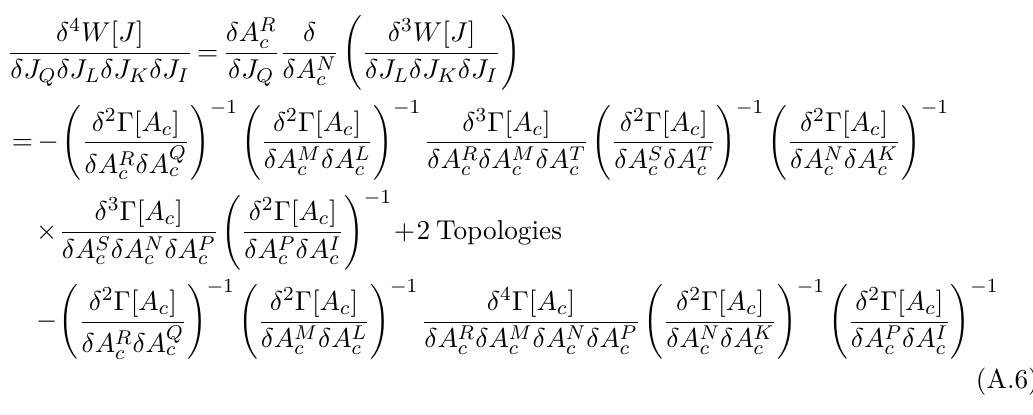
Figure 14 . The figure represents the geometries obtained via the fourth derivative of Γ[ A c ] . The first term is just the four point vertex. The remaining three are four point contributions obtained from the log term. For simplicity we suppress the symmetry factors, sign